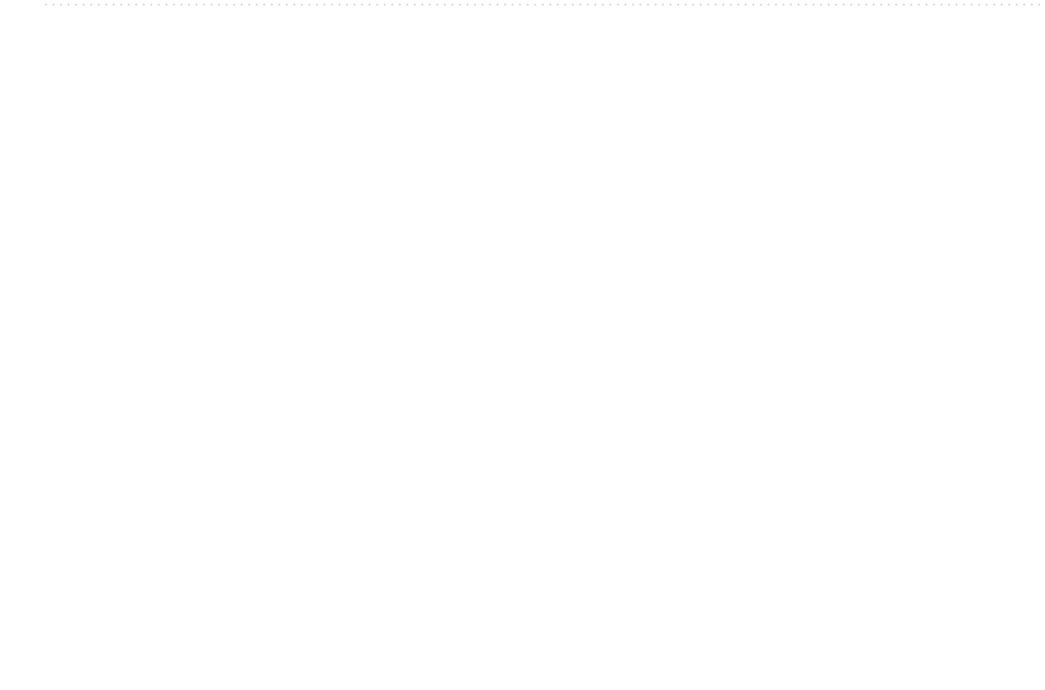
Figure 23. Linear dissipative 2DOF system